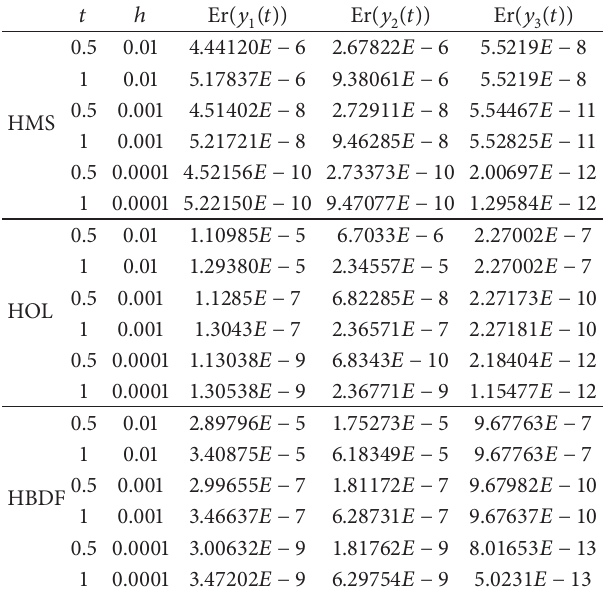
Table 2: The errors of solutions for the second test.